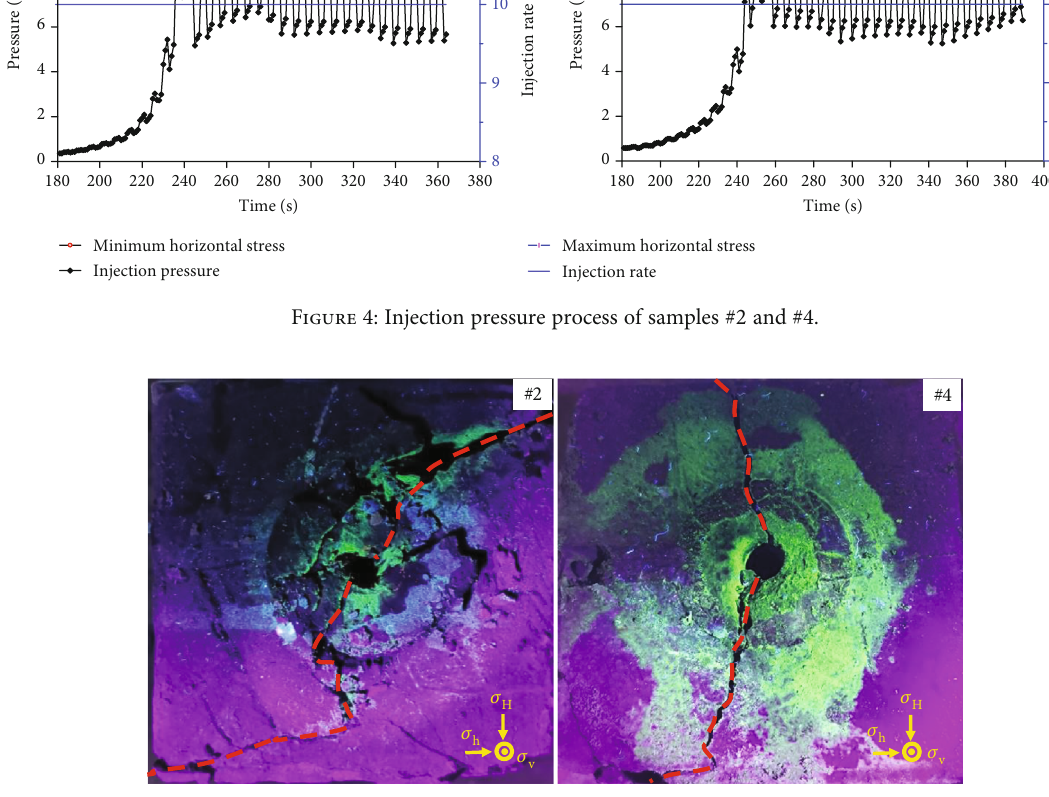
Figure 5: Fracture morphology with horizontal stress di ff